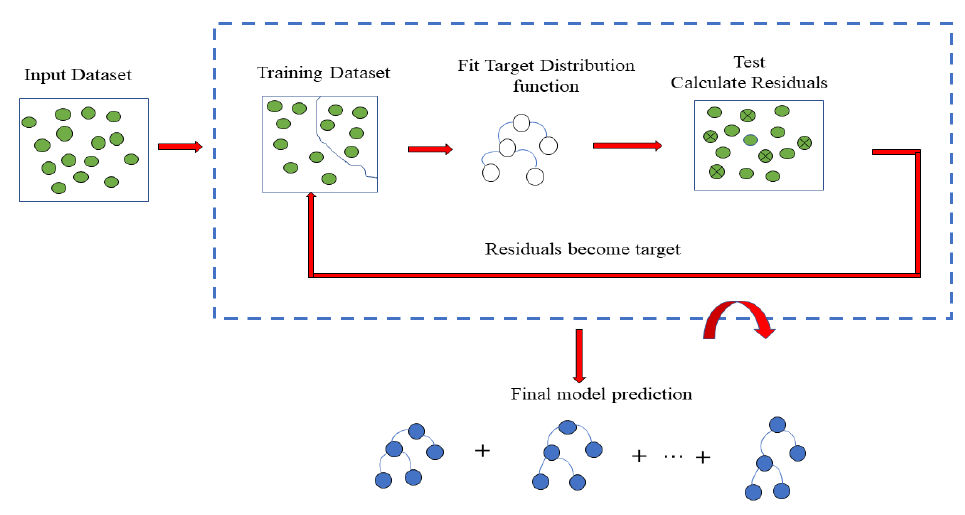
Figure 2. Gradient Boosting Machine Flow Chart.